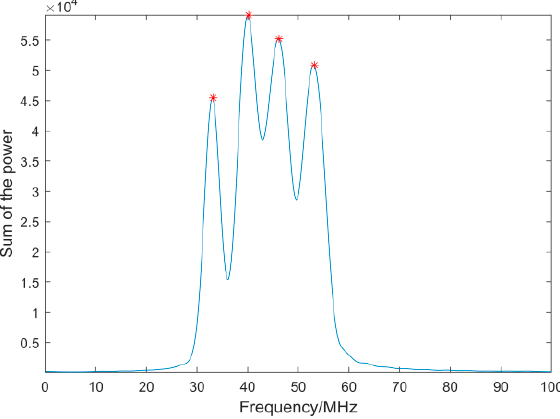
Figure 5. The sum of the power data.